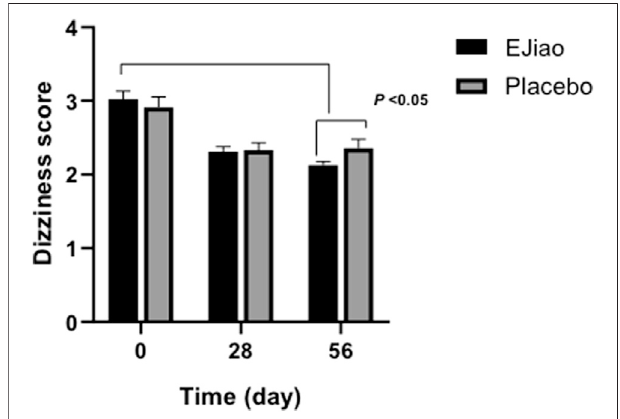
FIGURE 2 | The dizziness syndrome scores of the Placebo and Ejiao groups were evaluated after treatment for 28 and 56 days. After 56 days of administration of Ejiao (3 g, BID), there was a signi fi cant improvement in the symptoms of dizziness in the Ejiao group compared to the Placebo group and pretreatment state. Data are expressed as mean ± standard deviation. Intragroup and intergroup comparisons are calculated by means of paired samples t-test and independent samples t-test,